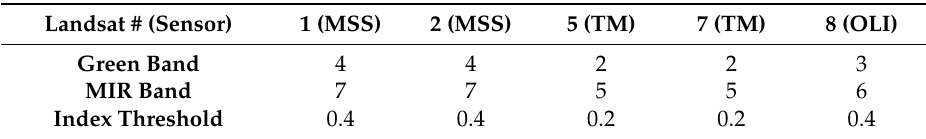
Table 1. Band selection for Landsat series to compute MNDWI and threshold used to distinguish water while index value >